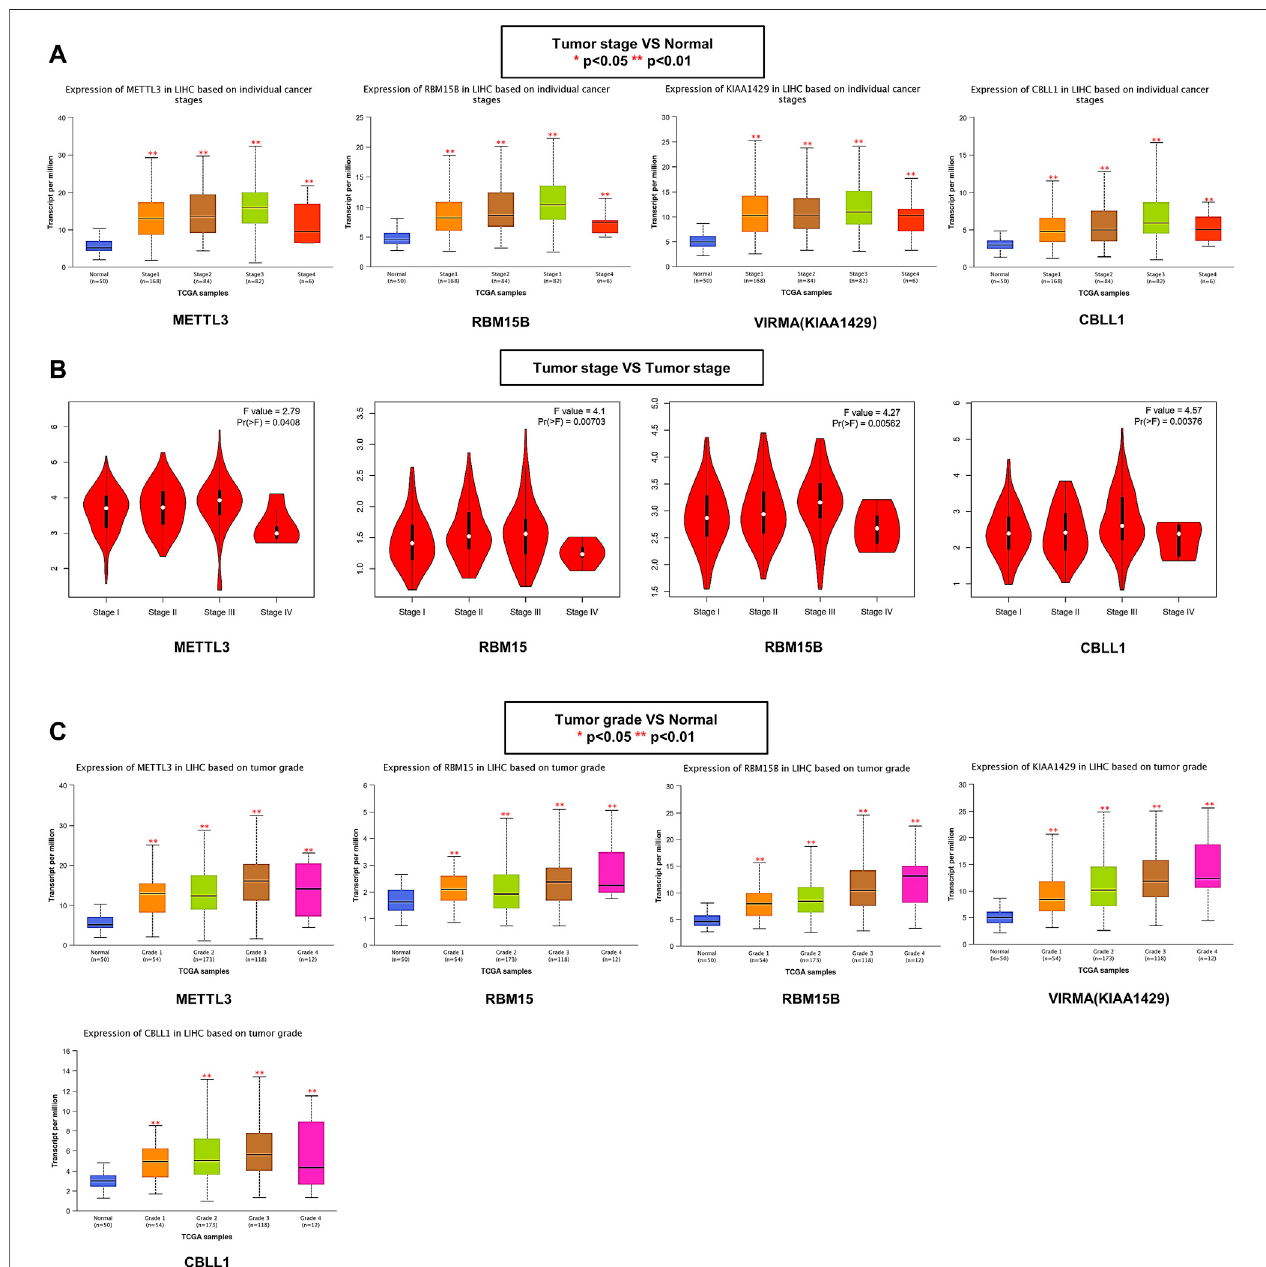
FIGURE 4 | Relationship between the m 6 A writer complex and clinicopathological parameters in HCC. (A) Association of mRNA expression of the m 6 A writer complexwith individualcancerstages inHCC (UALCAN). (B) Thecorrelationbetween m 6 Awriter complexexpression and tumor stage in HCC (GEPIA). (C) Association of mRNA expression of the m 6 A writer complex with tumor grades in HCC (UALCAN). ANOVA, p < 0.05 was regarded as statistically signi fi cant. * p < 0.05, ** p < 0.01, *** p < 0.001.